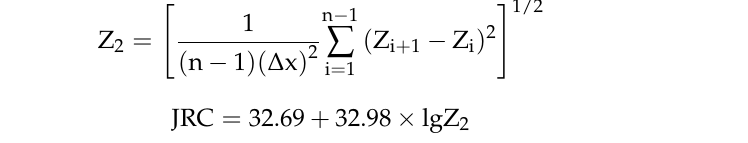
where Z 2 is the root mean square slope of the profiles based on the extracted data, Z i represents the coordinates of the fracture surface profile, n is the number of data points, and ∆ x is the interval between the data points. Specifically, the mean JRC values of Samples G1, G2, G3 were 13.01, 13.50, and 13.97, respectively.